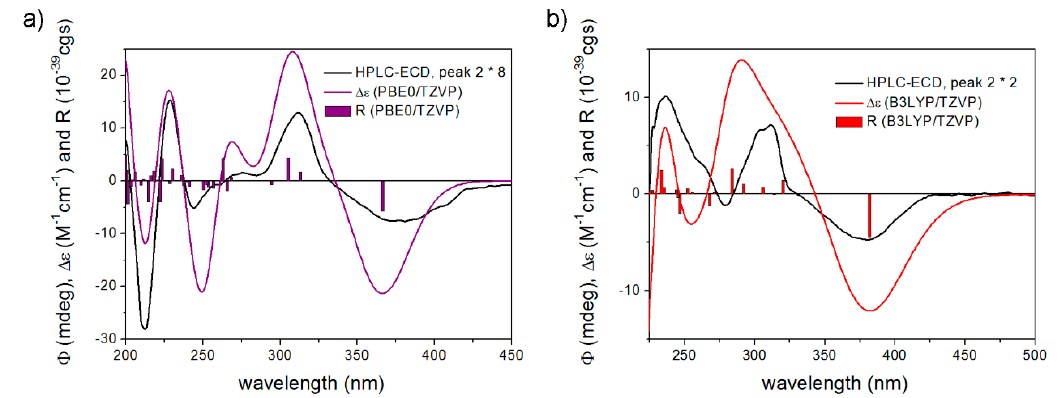
Figure 2. ( a ) Experimental HPLC-ECD spectra of the second-eluting enantiomer of 10a (black line) compared with the PBE0/TZVP PCM/ n -octanol spectrum of ( S )- 10a (purple line). ( b ) Experimental HPLC-ECD spectra of the second-eluting enantiomer of 11a (black line) compared with the B3LYP/TZVP PCM/ n -octanol spectrum of ( S )- 11a (red line). Level of DFT optimization: CAM-B3LYP/TZVP PCM/ n -octanol. Bars represent the computed rotational strength values.